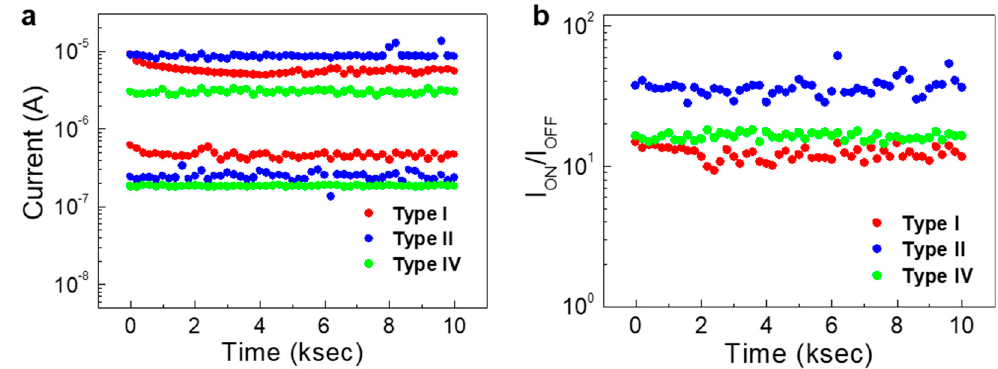
Figure 3. ( a ) The data retention characteristics of TiO x -based memristors (type I, II, and IV). The ON and OFF states were programmed with biases of + 3 V and − 3 V, respectively. Also, the read voltage was + 1 V. ( b ) The variation of I ON / I OFF ratio during the data retention test up to 10 ks.